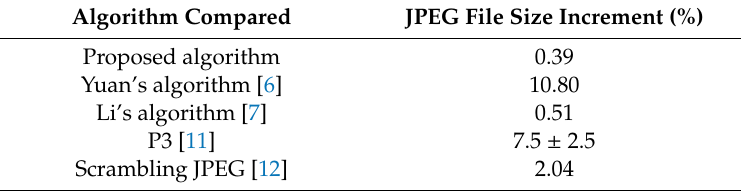
Figure 6. JPEG images obtained from the visually transformed ones. Table 1. Comparisons between five algorithms for content protection in JPEG images.